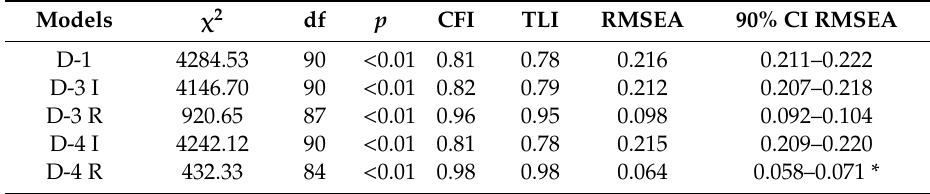
Table 3. Fit indexes for the model